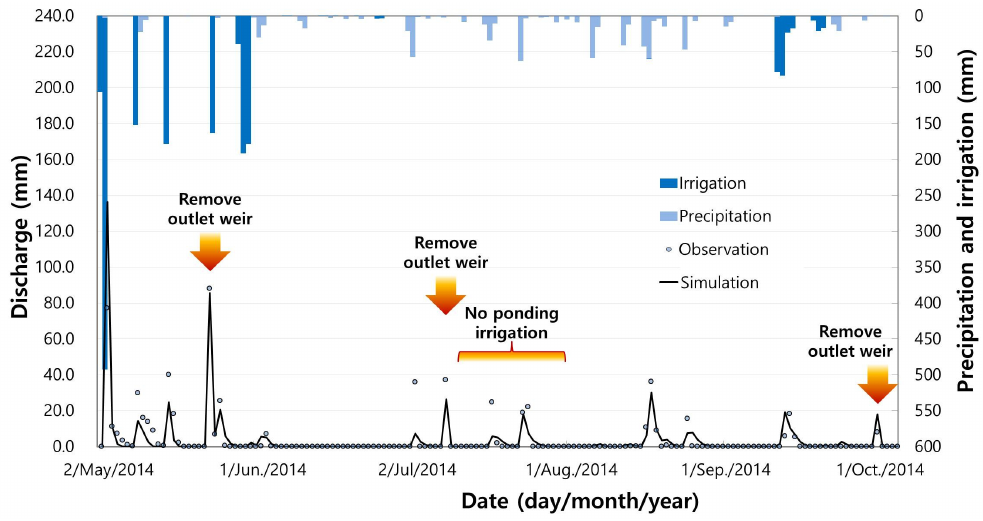
Figure 5. Simulated discharge amounts indicate that the timing and magnitude of peak discharges in response to outlet weir management are well predicted during the growing season in 2014 at the Gimje site.